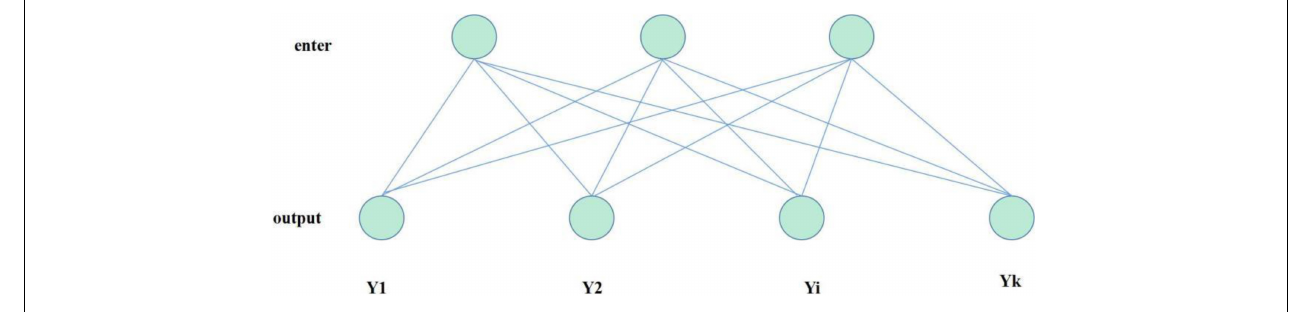
FIGURE 6 | Full connection